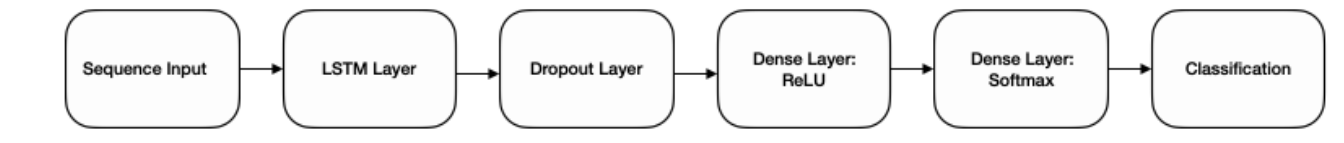
Figure 14. LSTM network architecture of Experiment